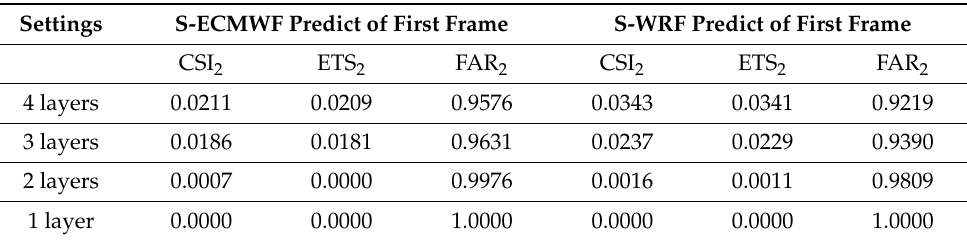
Table 8. Ablation experiments conducted on two datasets to examine the relationship between the number of layers and prediction effect of the HDGN